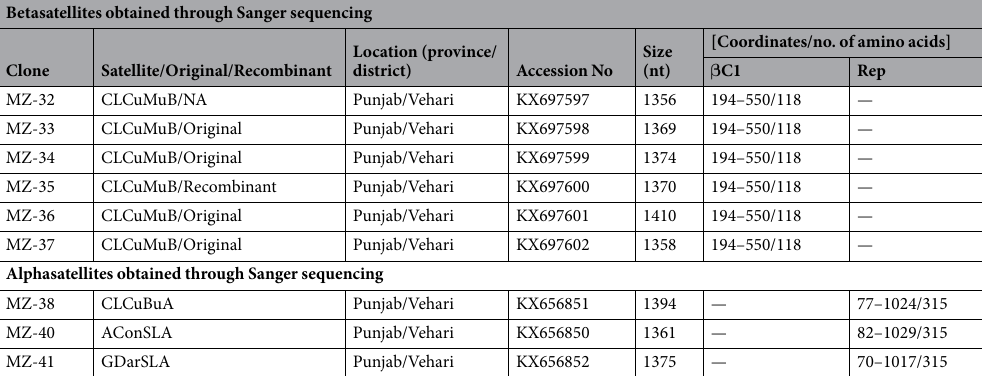
Table 3. Features of betasatellites and alphsatellites obtained through Sanger